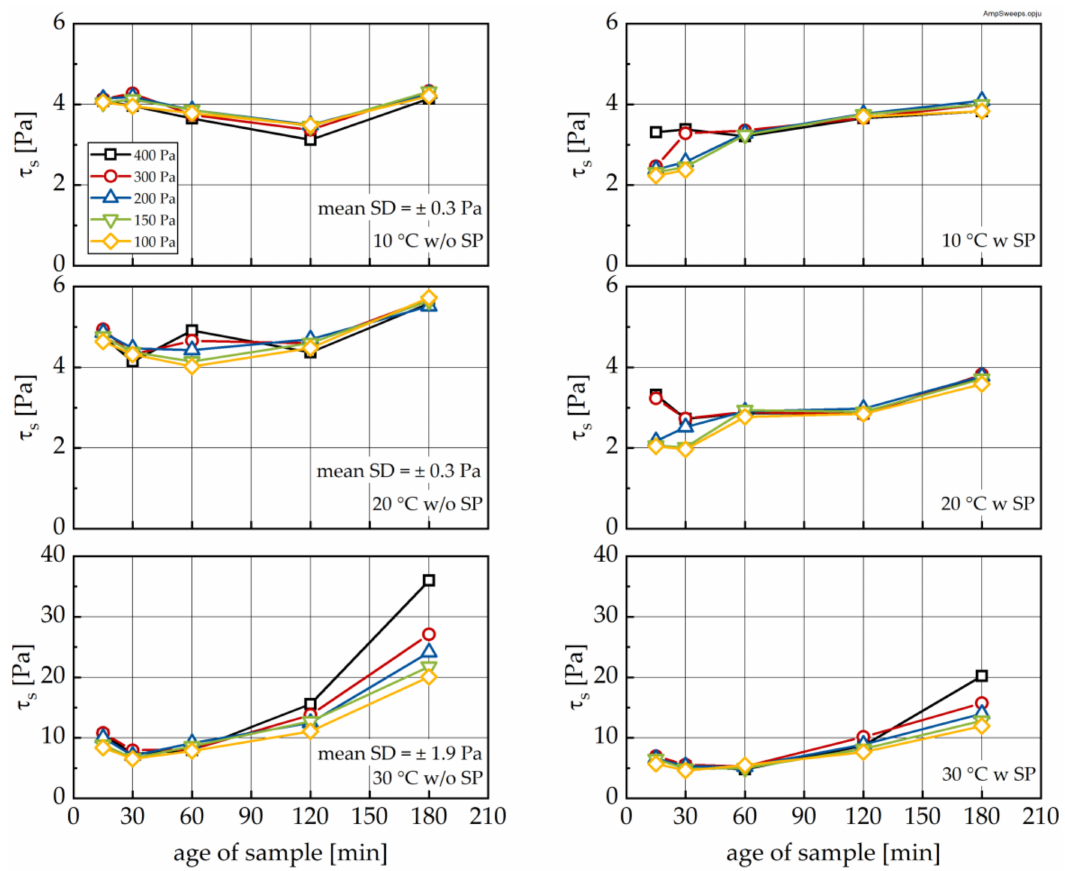
Figure 12. Structural limit stress τ s measured after the recovery phase RP as a function of time without (left) and with SP addition (right) for di ff erent pre-shear stresses at 10 ◦ C (top), 20 ◦ C (middle) and 30 ◦ C (bottom), respectively. Mean standard deviation (SD) calculated from three repetitions and all shear stresses at corresponding temperature without